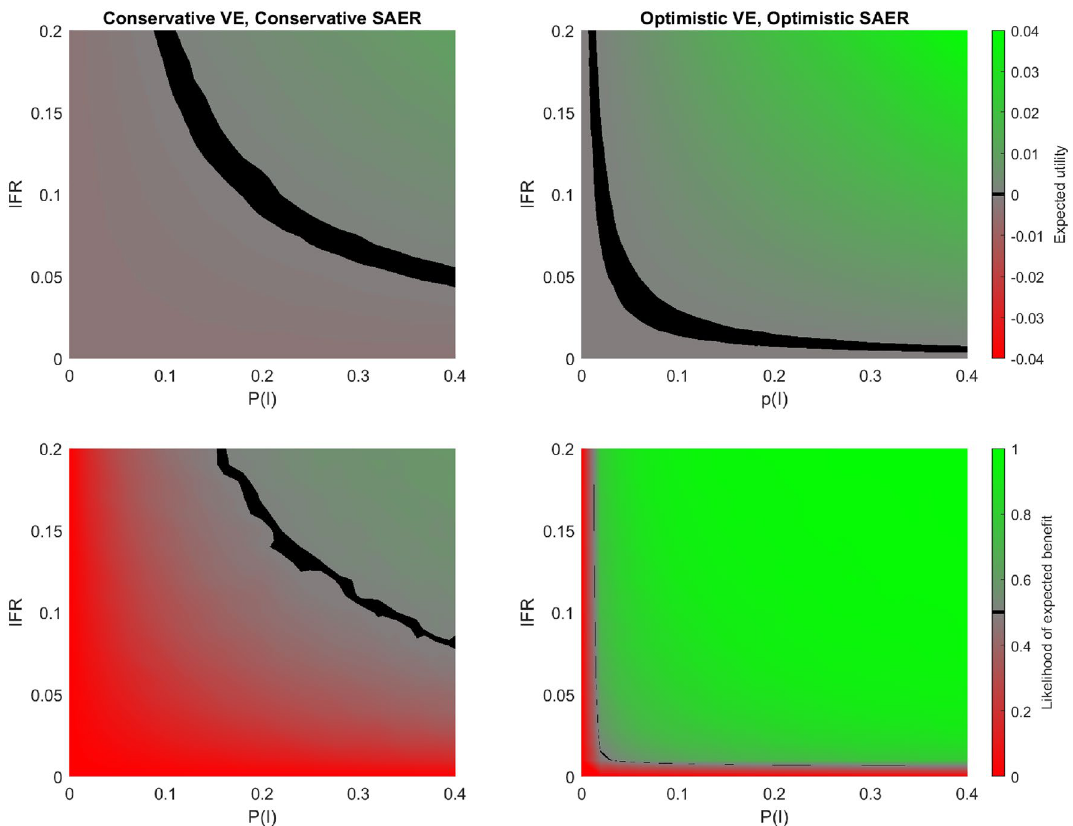
Figure 3. Expected utility (top row) and likelihood of expected benefit (bottom row), for the model of emergency COVID-19 vaccination with conservative (left column) and optimistic (right column) estimators for VE and SAER. Green denotes positive utility or likelihood of expected benefit > 0.5, and red the opposite. The black region corresponds to that of approximate equipoise between emergency vaccination or not: − 0.0005 < Expected Utility ≤ 0.0005 and 0.495 < Likelihood of expected benefit ≤ 0.505 respectively. The optimistic estimators result in emergency vaccination being beneficial across a greater proportion of the [P(I),IFR] parameter space. However, with either conservative or conservative expectations, those at high risk of COVID- 19 - the top right region of these graphs - can expect significant